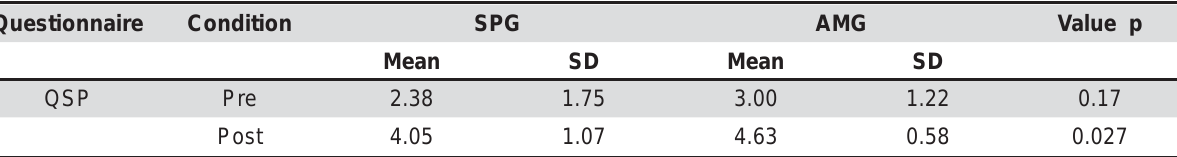
Table 2- Mean and standard deviation of the SPG and the AMG in the Problem Situation Questionnaire, under pre- and post-test